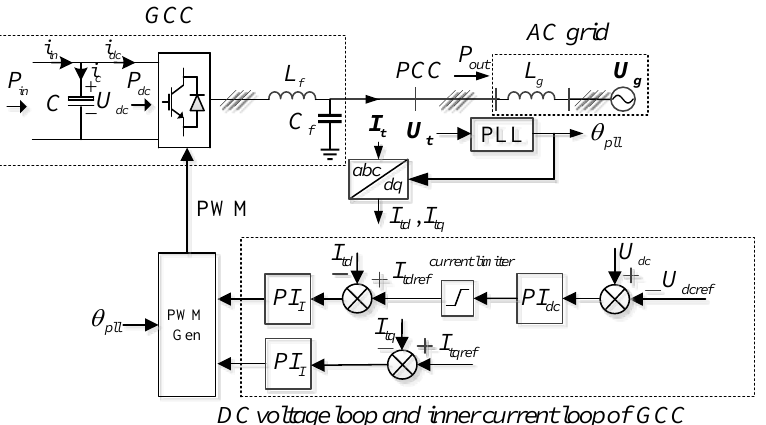
Figure 1. The typical control diagram of grid-connected converter (GCC) connected to the AC grid.